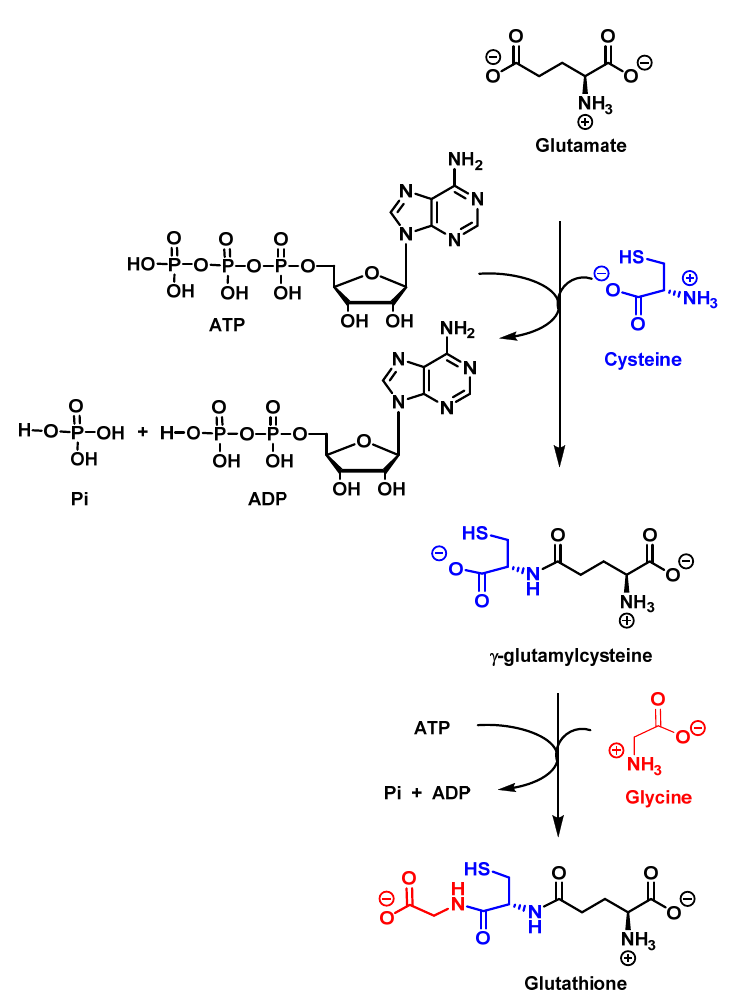
Figure 4. Ex-novo synthesis of glutathione. Glutamate and cysteine are combined by the enzyme glutamate-cysteine ligase (GCL) to form glutamyl-cysteine, which is then combined with glycine by glutathione synthase (GS). Glutathione (GSH) is synthesized in a 2-step reaction, requiring two molecules of ATP, which are transformed into ADP and Pi. One molecule of ATP is consumed in each step of GSH synthesis.